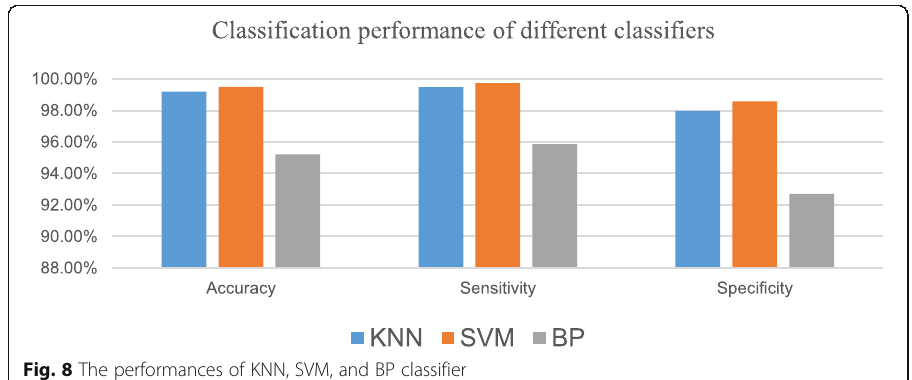
Fig. 8 The performances of KNN, SVM, and BP classifier